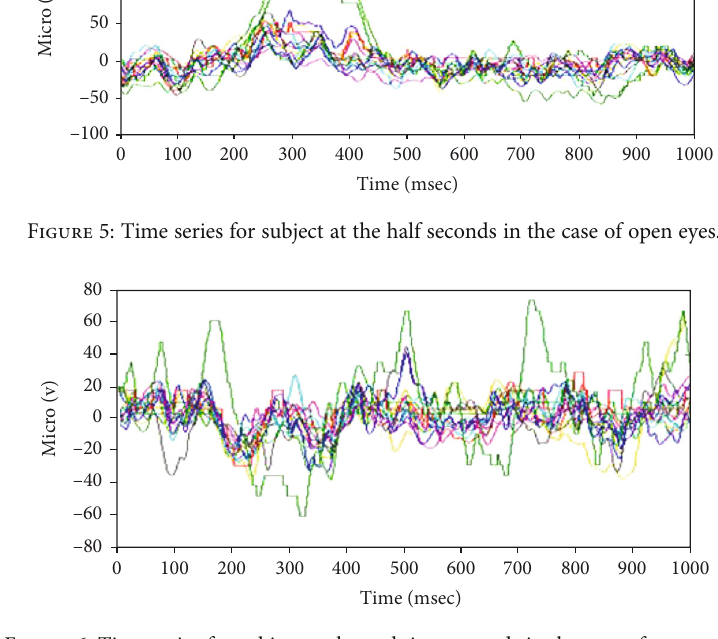
Figure 6: Time series for subject at the end time seconds in the case of open eyes.